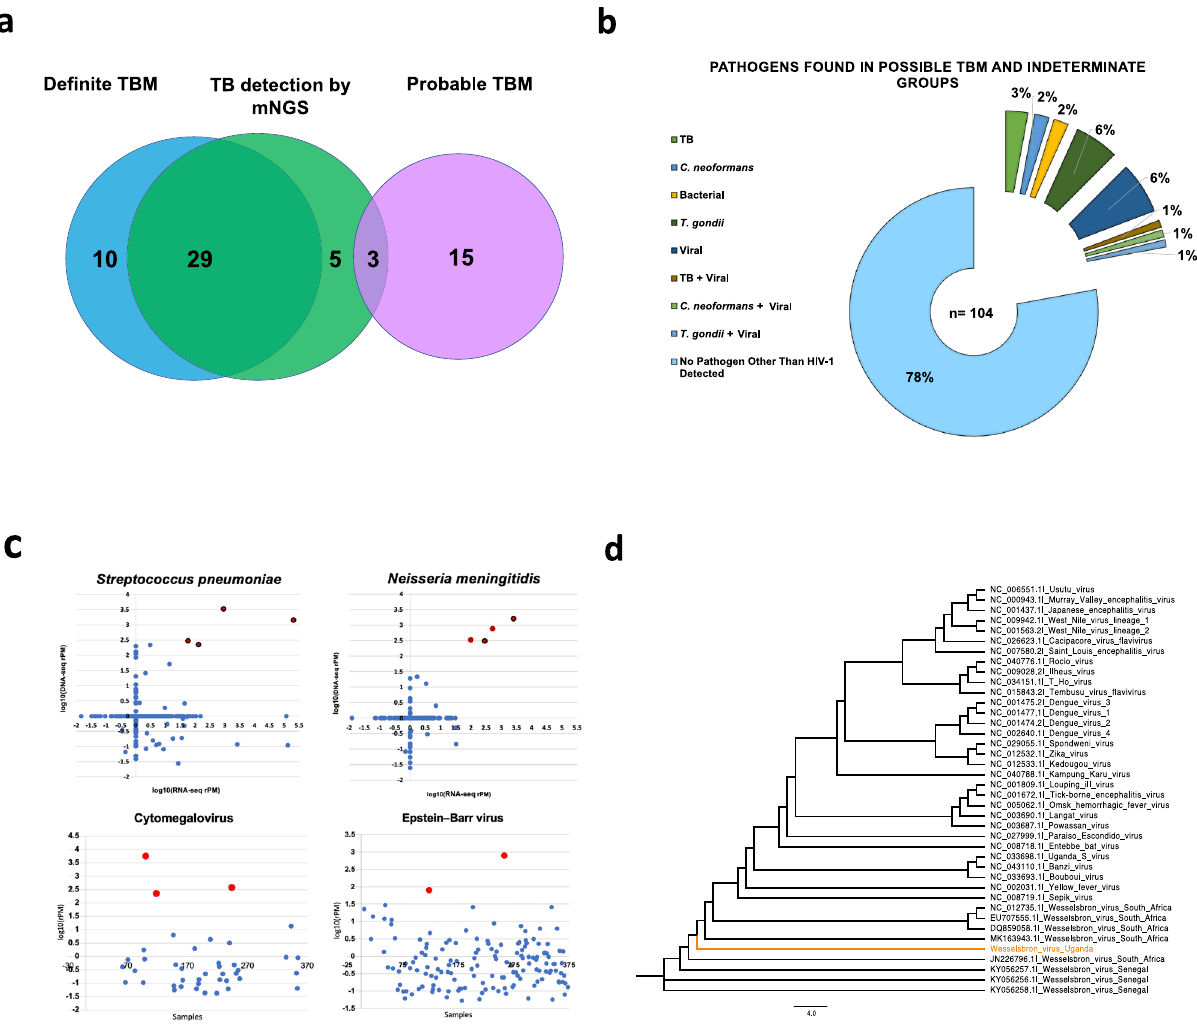
Fig. 2 Pathogen detection by mNGS. A Detection of TB for entire cohort. Blue circle represents de fi nite TBM (i.e., detected by GeneXpert Ultra and/or culture). Pink circle represents probable TBM cases based on clinical consensus but GeneXpert Ultra and/or culture negative. Green circle is TBM detected by mNGS. Five additional cases of TBM were detected in possible TB, indeterminate and Not-TBM groups. B Breakdown of pathogens found in possible TBM and indeterminate groups. C Top two graphs are log10(rPM) for normalized DNA-seq and RNA-seq reads to Streptococcus pneumoniae and Neisseria meningitidis detected in every sample sequenced. Red dots indicate samples with greater than 1 log fold abundance greater than the mean cohort abundance in both the DNA-seq and RNA-seq datasets relative to the remaining cohort. Red dots circled in black indicate samples that were diagnosed as bacterial meningitis during hospital admission in Uganda. Bottom two graphs demonstrate a similar method performed for Epstein-Barr virus and cytomegalovirus as both these viruses can be seen in low abundance in neuroin fl ammatory conditions. Red dots indicate samples with Epstein-Barr virus or cytomegalovirus with rPM 2 log fold higher than the mean cohort abundance in DNA-seq. D Phylogenetic tree for Wesselsbron virus detected in 1 patient in the possible TBM group. Phylogenetic tree was built with a multiple sequence alignment using the assembled genome and reference genomes obtained from National Center for Biotechnology Information. The best- fi tting evolutionary model was picked by ModelTest-NGv0.1.5, and a phylogenetic tree was built using RAxML-ng v0.6.0. Scale bar indicates length associated with 4.0 nucleotide substitutions. TBM tuberculous meningitis, TB Mycobacterium tuberculosis, mNGS metagenomic next-generation sequencing, RNA-seq ribonucleic acid sequencing, DNA-seq deoxyribonucleic acid sequencing, rPM reads per million. Source data are provided as a Source Data fi Based on these results, the optimal sequencing depth for the sequencing model. The MLC had an AUC of 0.76 ( p = 0.01) with a detection of non-TBM pathogens was considered 100,000 paired- sensitivity of 77.8 (CI:40 – 97.2%) and a speci fi city of 78.7 end reads for RNA-seq and 500,000 pair end reads for DNA-seq. (CI:67.8 – 87.3%). The combined MLC and mNGS assay had an While TB detection by mNGS at shallow sequencing depths was AUC of 0.88 ( p = 0.0002) with a sensitivity of 88.9% insensitive, the MLC classi fi er still maintained similar sensitivity to (CI:51.8 – 99.7%) and a speci fi city of 88% (CI:78.4 – 94.4%) (Fig. 1C). classify TBM at 100,000 paired-end reads. We therefore reran all microbiologically proven samples from the fi nal test cohort ( n = 84) at 100,000 reads for RNA-seq and 500,000 reads for Cost analysis . At a depth of 100,000 reads for the RNA library DNA-seq for through the MLC and the open source, cloud-based and 500,000 reads for the DNA library, one sample would require metagenomics pipeline (Chan Zuckerberg ID or CZID) 26 pipeline 600,000 total paired-end reads. An Illumina iSeq generates to assess AUC, sensitivity and speci fi city of our in silico low depth 8,000,000 paired-end reads per fl ow cell. Thus, at 600,000 reads